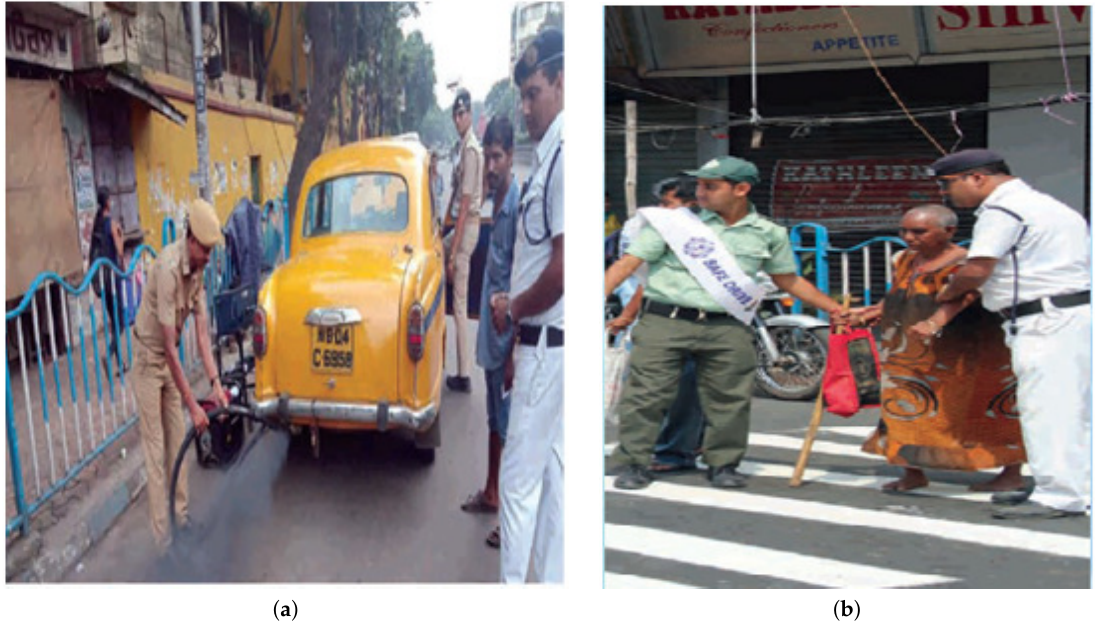
Figure A1. ( a ) Vehicle emission checking at roadside ( b ) Role of Civic-Volunteers (Kolkata Tra ffi c Police Annual Review 2017, Pages 46 and 15).